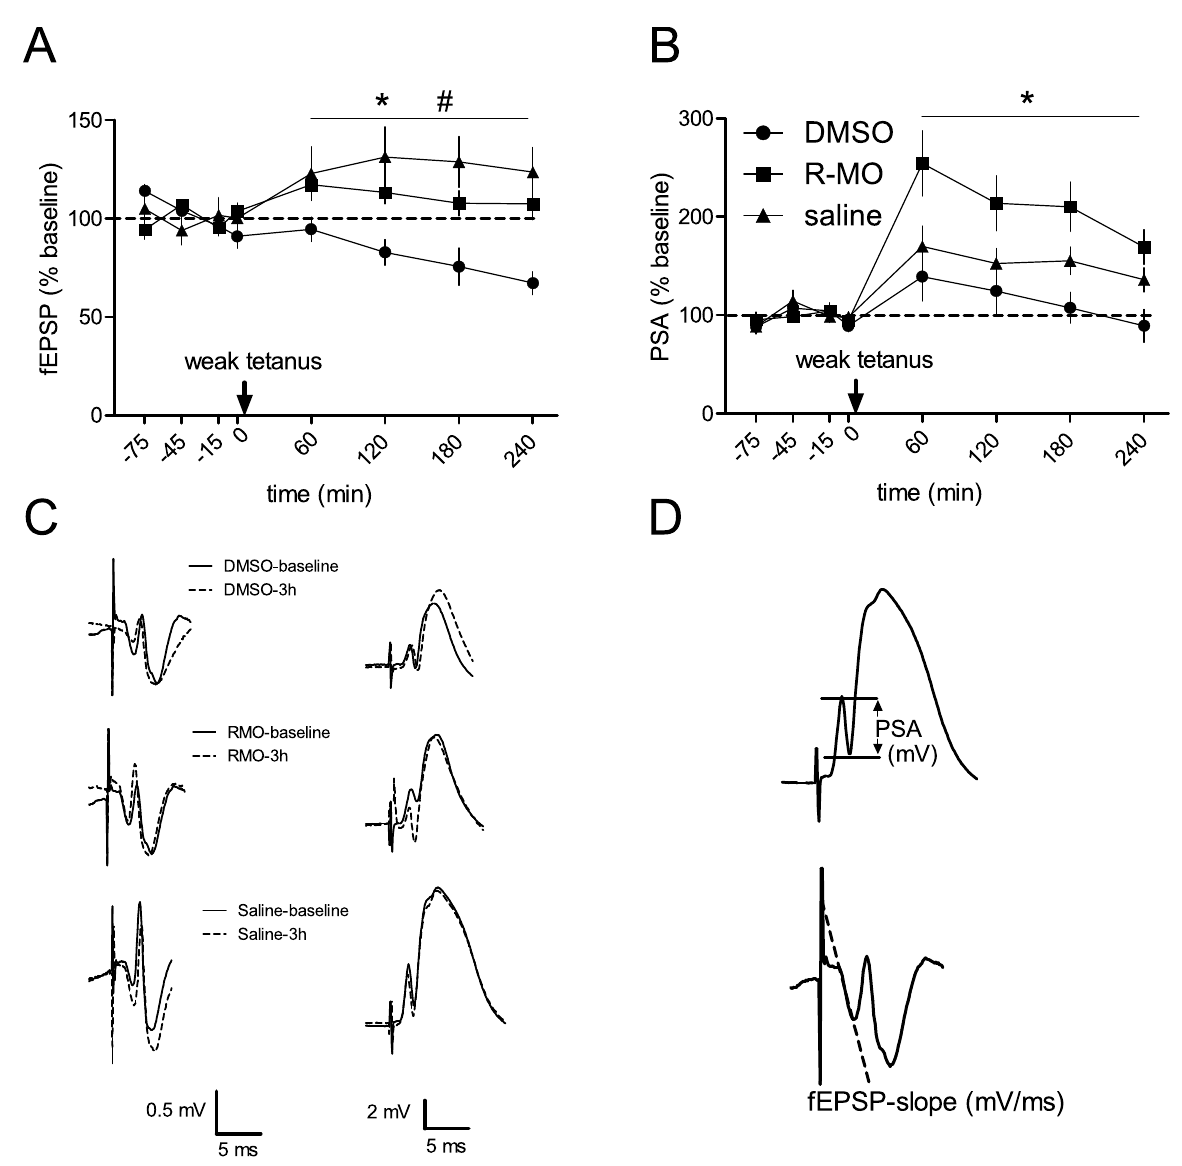
Fig 4. Effect of treatment on field potential measurements in DG: Stimulation with weak tetanus. Data was analyzedwith two- way repeatedmeasureANOVA. Multiplecomparisonwith Dunnett t (2-sided) test revealsdifference betweengroupsin fEPSP (A) and in PSA (B) measurements. * dmso vs 10 mg RMO (p < 0.05), # saline vs dmso (p < 0.05). Graphs shows mean ± SD. (C) ElectrophysiologicalfEPSP (left panel)and PSA (right panel)analogue traces of baselineand 3h post LTP inductionare given for DMSO, RMO and saline. (D) Analoguetraces of PSA and fEPSP with marks of points of measurement.